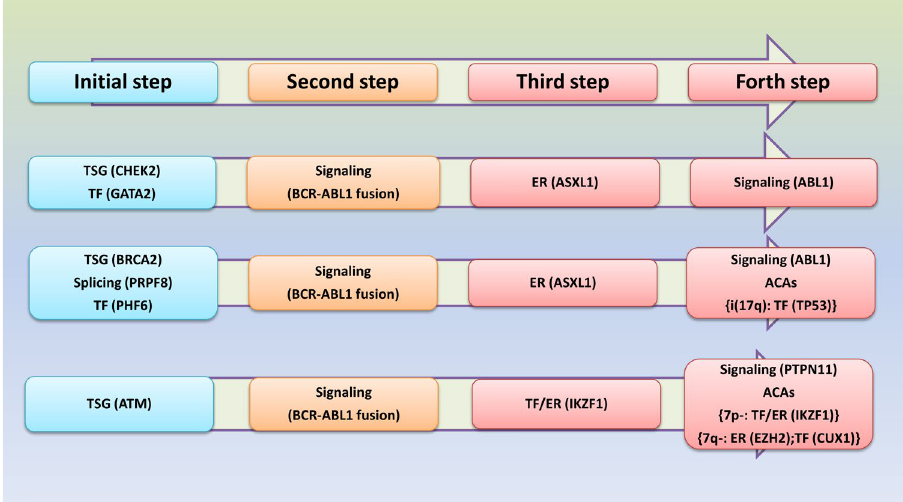
Figure 5. A suggested model of leukemogenesis. In this model the initial step is the presence of mildly- deleterious variants which may affect the tumor suppressor genes (TSG), transcription factors (TF) and/or components of splisosome and increase susceptibility to cancer. In the second and third steps, the major genetic findings are BCR-ABL1 fusion gene and mutation in the epigenetic regulator (ER)/transcription factor (TF) genes. The final step in the accelerated and blast crisis phase may be started by the mutations in the signaling molecules and/or additional chromosomal abnormalities